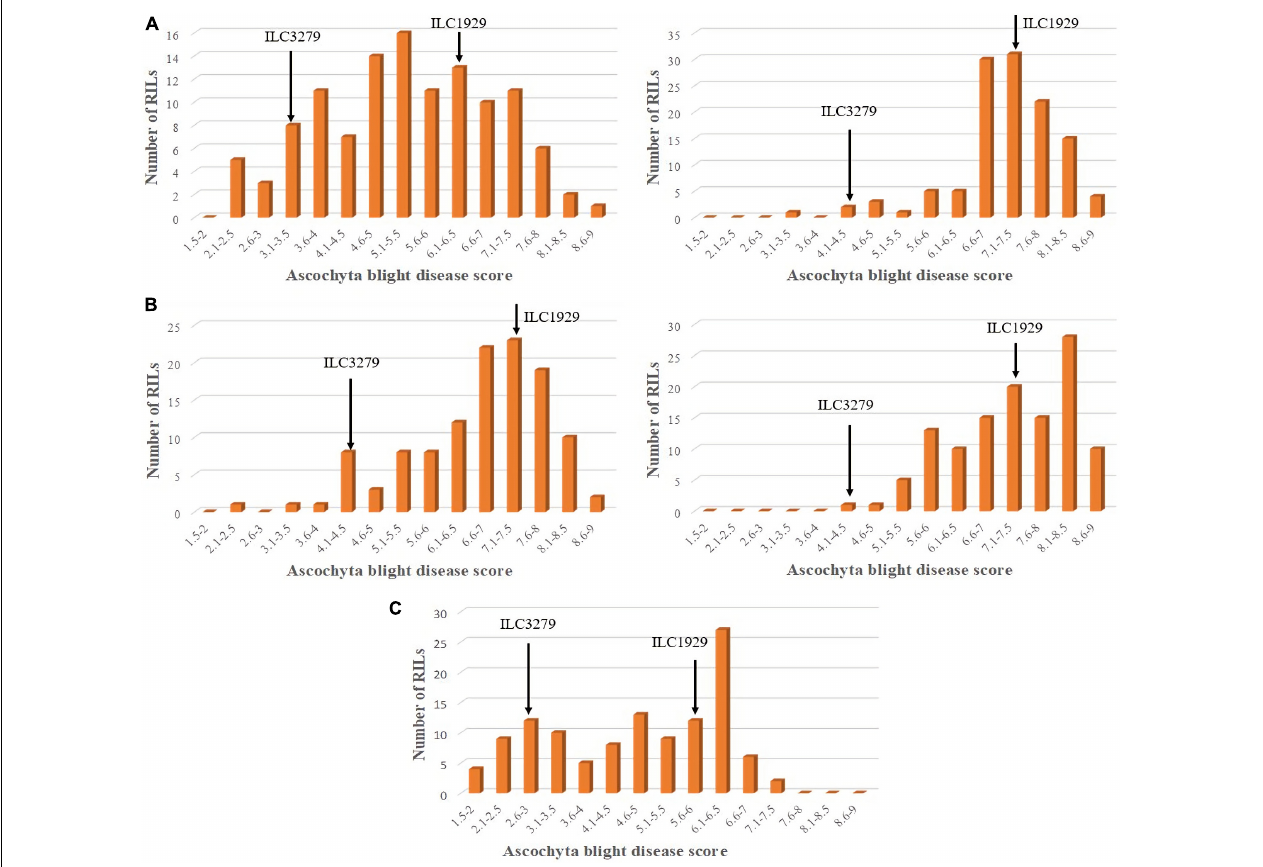
FIGURE 1 | Frequency distribution of Ascochyta blight (AB) disease scores in 116 recombinant inbred lines (RILs) of the AB 3279 chickpea population developed from a cross between “ILC1929” and “ILC3279.” The mean disease score was used to calculate the frequency distribution of disease severity for pathotypes I and II under greenhouse (A) , and fields conditions at Kfarshakhna in 2015 and 2018 (B) , and Punjab Agricultural University (PAU) Ludhiana in 2017 (C) . The arrows represent the mean scores of the resistant “ILC3279” and susceptible “ILC 1929” parents.